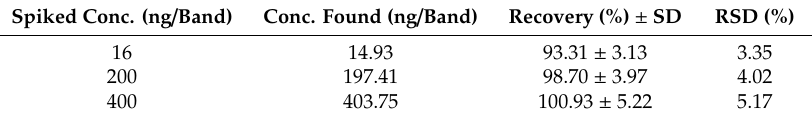
Table 4. Recoveries of DLX from spiked human plasma ( n = 6).